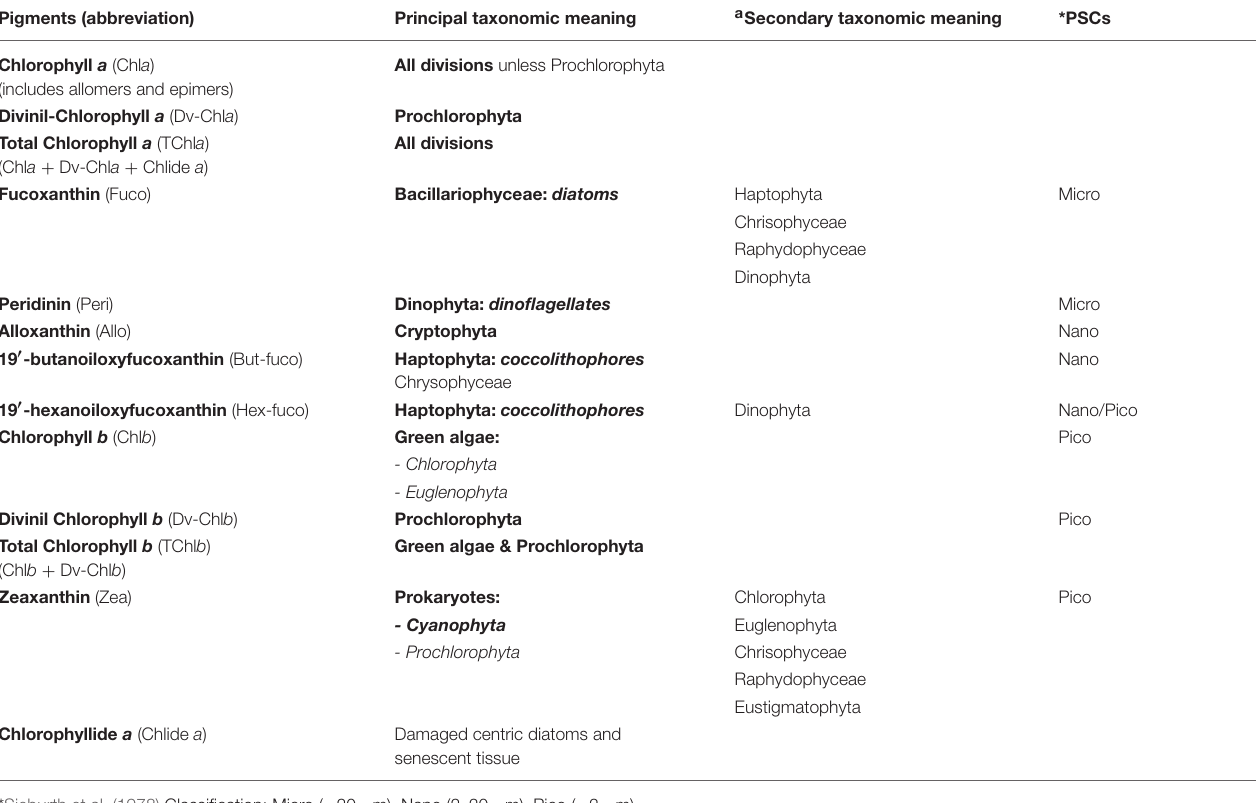
TABLE 1 | Diagnostic Pigments (DP) and their taxonomic meaning in microalgal divisions or classes (Jeffrey and Vesk, 1997; Prezelin et al., 2000; Vidussi et al., 2001; Wright and Jeffrey, 2006; Ras et al., 2008; Brunet and Mangoni, 2010 ). Pigments